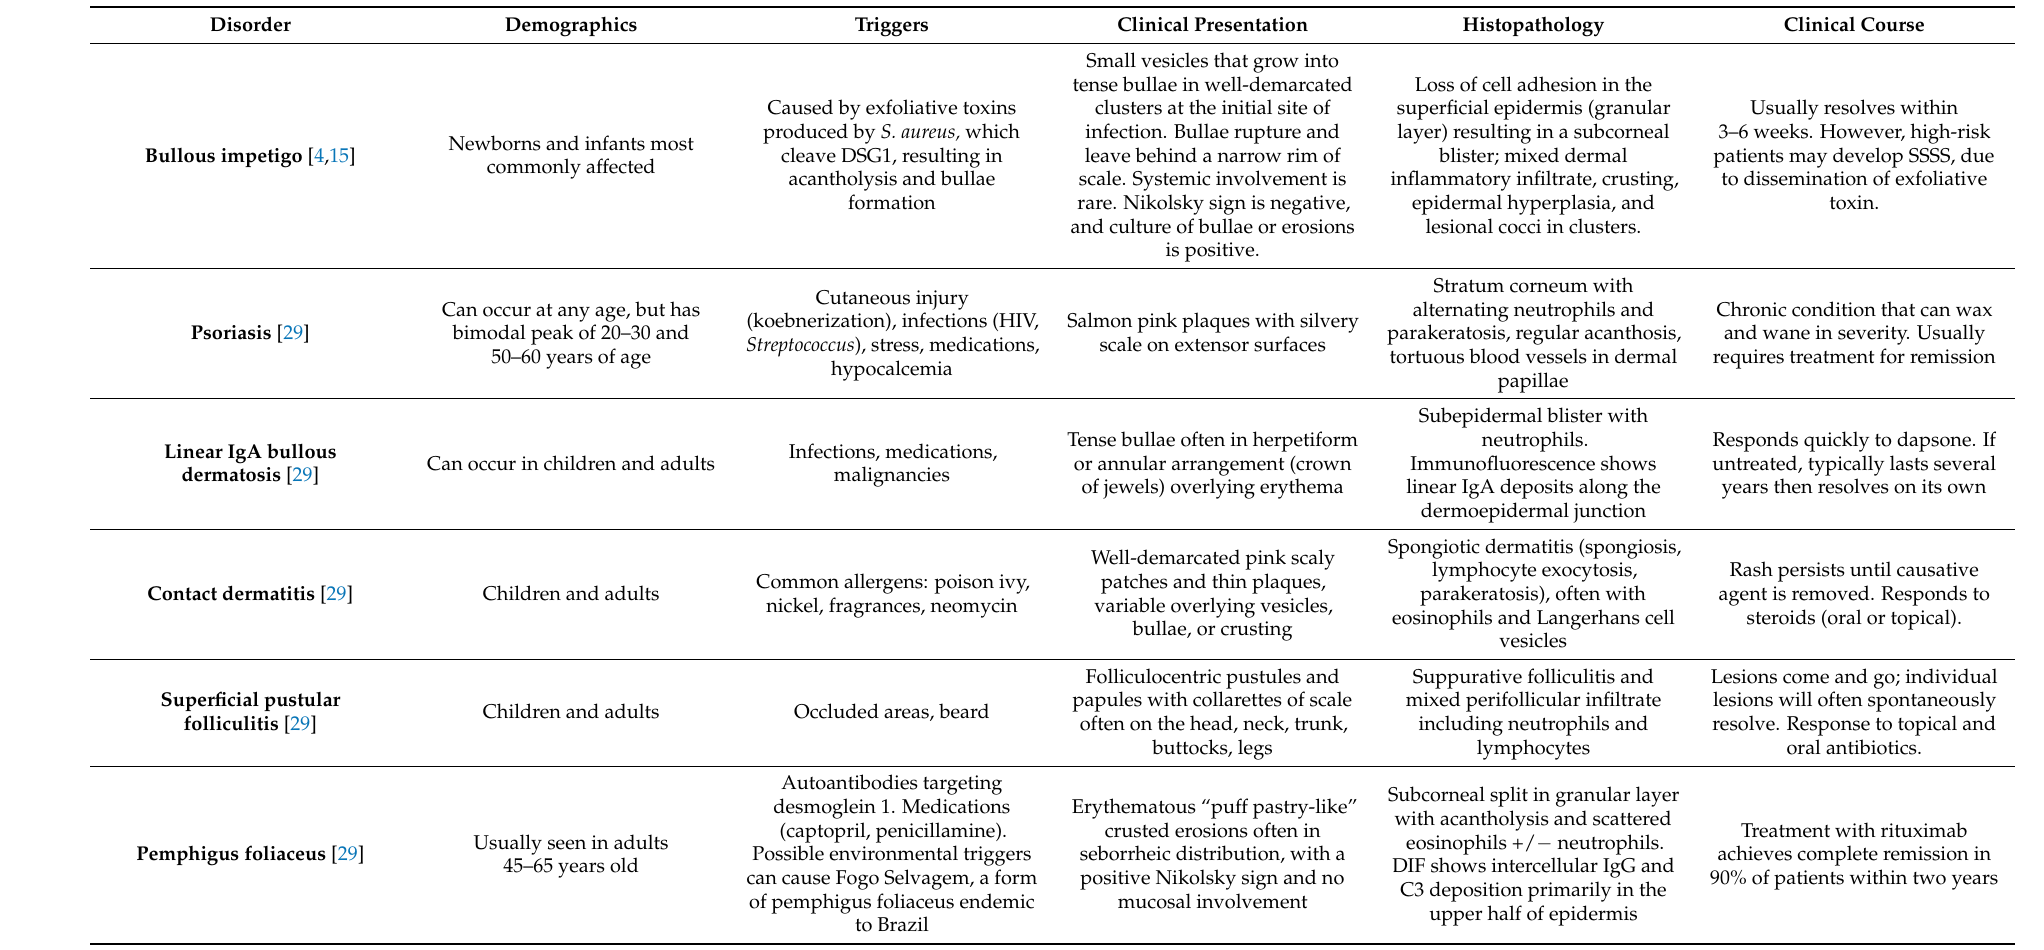
Table 3. Differential diagnosis of bullous